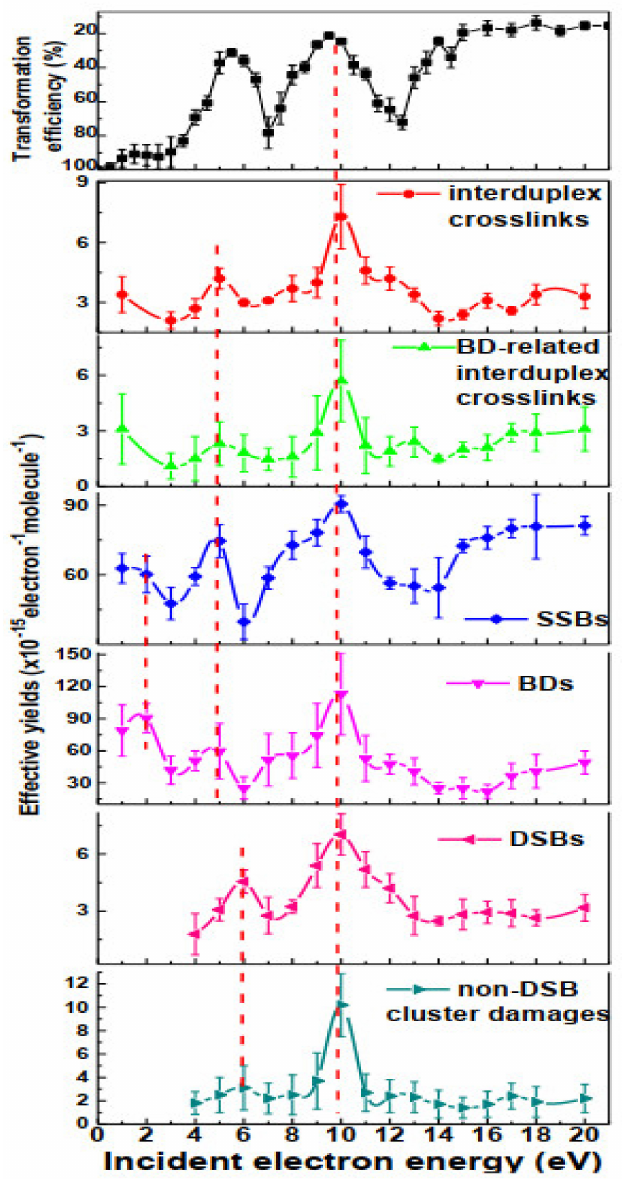
Figure 2. The upper frame is the complement of the transformation efficiency of JM109 E. coli cells, containing PGEM3Zf( − ) plasmids bombarded with LEEs of 0.5 to 21 eV [137]. It is compared to the single-electron yields of interduplex and BD-related interduplex crosslinks, SSBs, BDs, DSBs, and non-DSB clustered damage, recorded as a function of electron energy. The dotted lines indicate the energies of TAs at 2, 5, 6, and 10